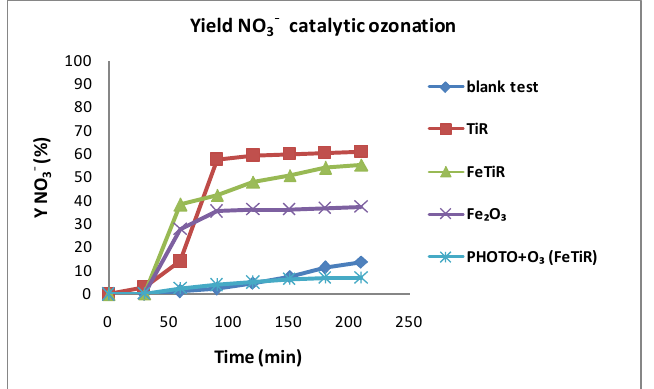
− vs. time for ammonia ozonation in addition to Figure 16. Yield of NO 3- vs. time for ammonia ozonation in addition to photo-oxidation. Figure 16. Yield of NO 3